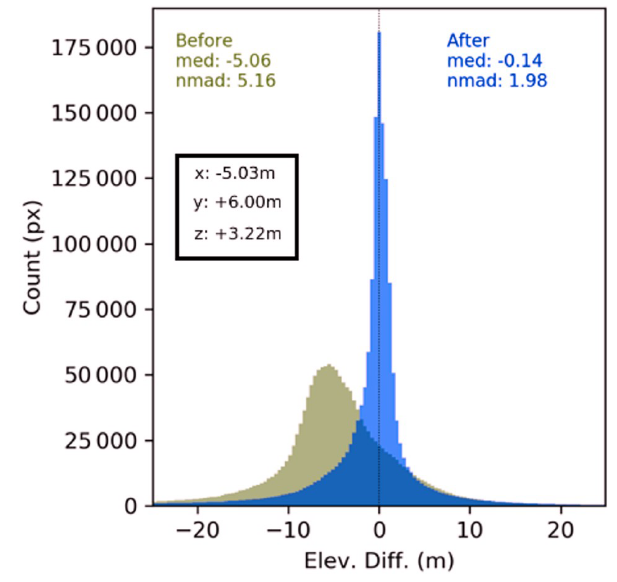
Figure 8. DEM error (elevation difference between the reference and source DEM) distribution for stable